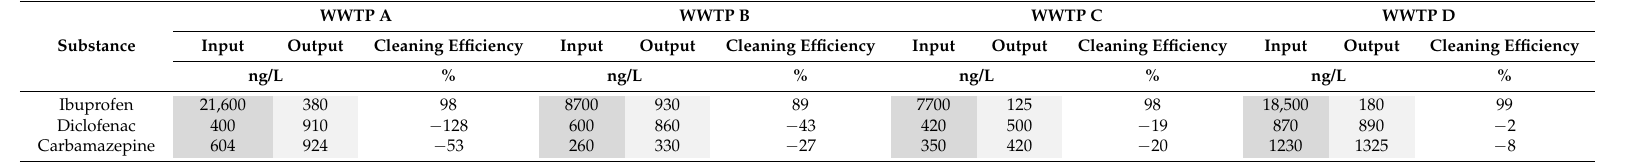
Table 2. Average value from four large sewage treatment plants (A–D) in Bohemia in 2009–2011.